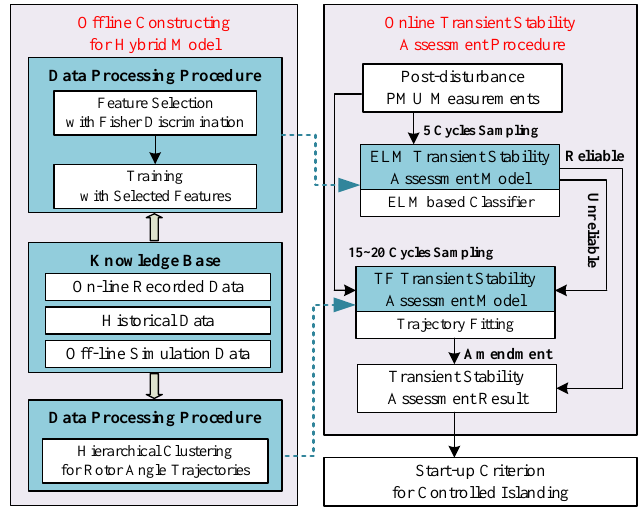
Figure 1. Construction and work-flow of the hybrid transient stability assessment model.